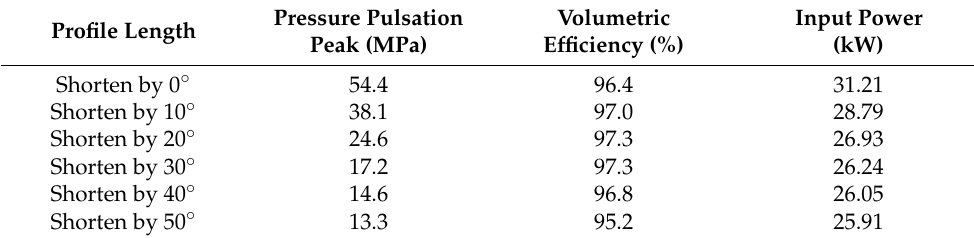
Table 4. Volumetric efficiency under different profile